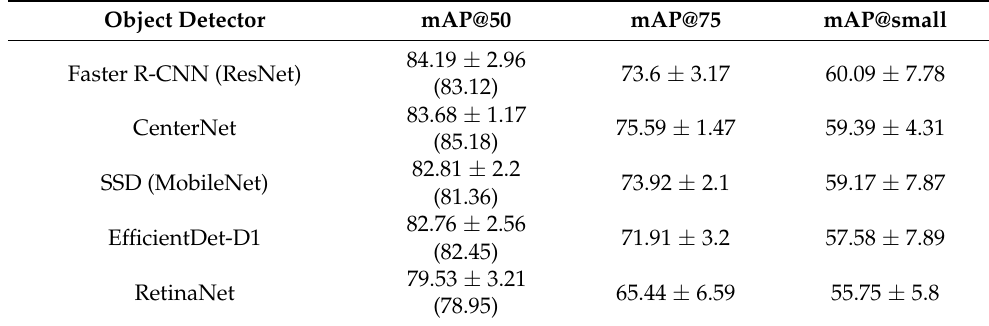
Table 5. The performance of each architecture with only geometric augmentation active. In the parentheses, the training performance is presented for